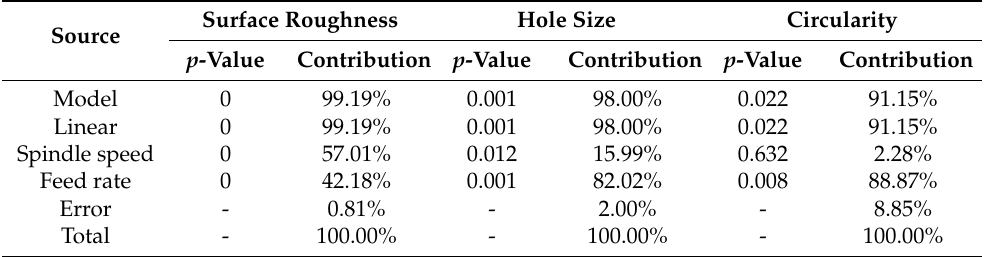
Table 2. ANOVA results.